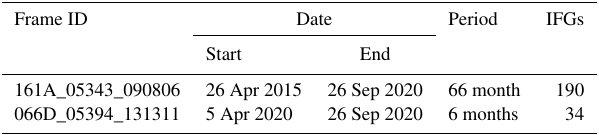
Table 2. LiCSAR frames, analysis periods, and the total number of IFGs used in this study.